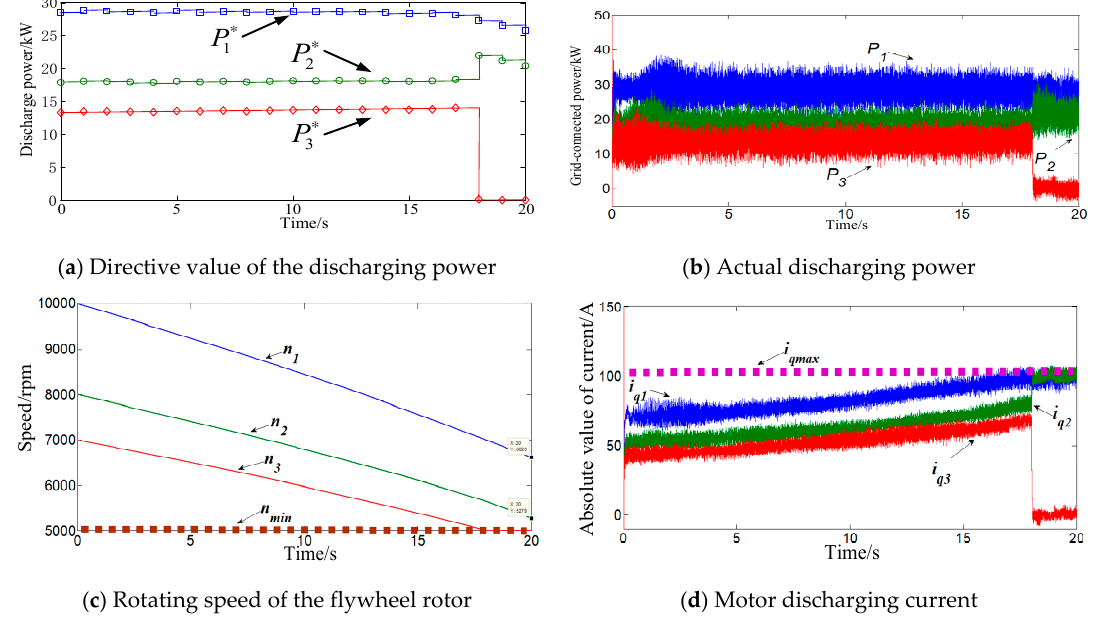
Figure 22. Simulation waveforms of the discharging power distributed by the EIP.